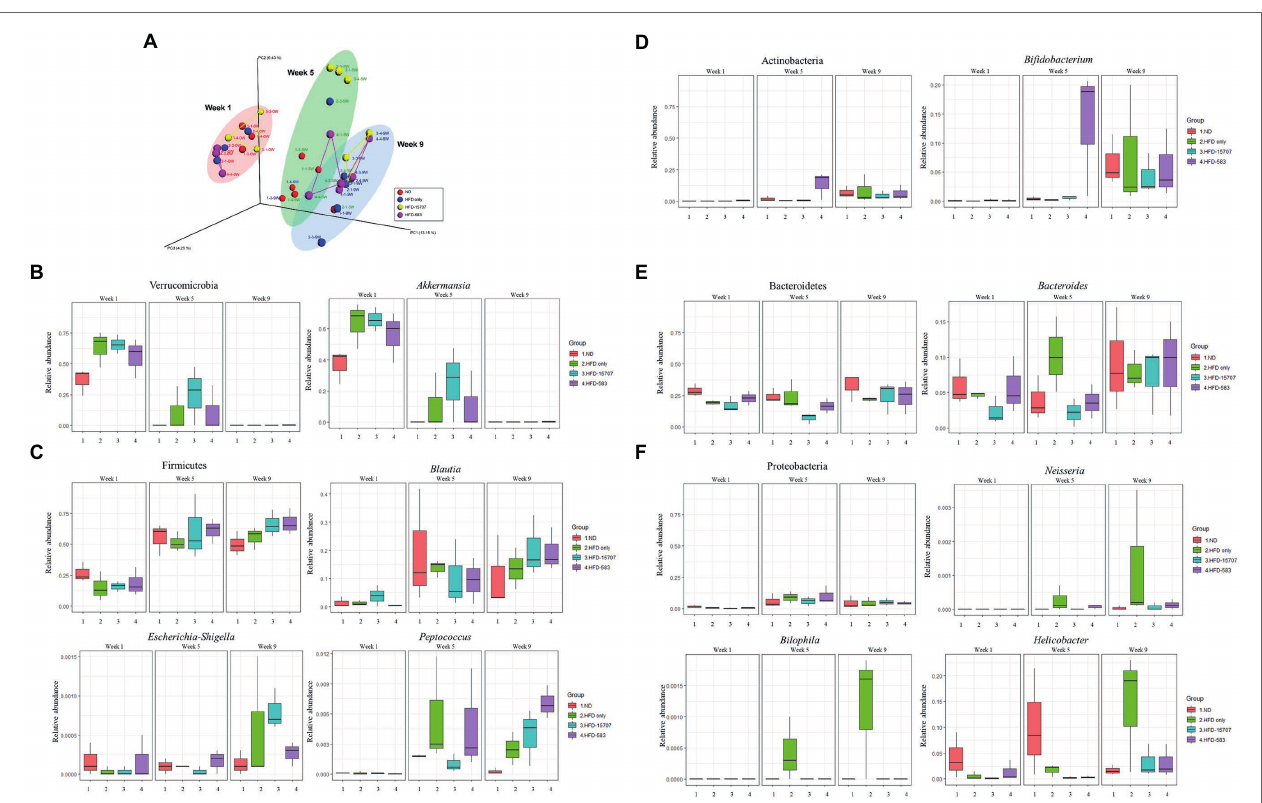
FIGURE 6 | Principal coordinates analysis (PCoA) and microbial compositional changes of representative phyla and genera of four groups in Week 1, Week 5, and Week 9. (A) β -Diversity plot using UniFrac distance with four groups. (B–F) The major phyla and genera were indicated on the box